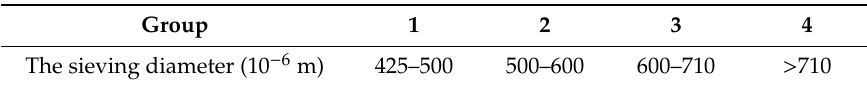
Table 2. Proppant subdivision standard.